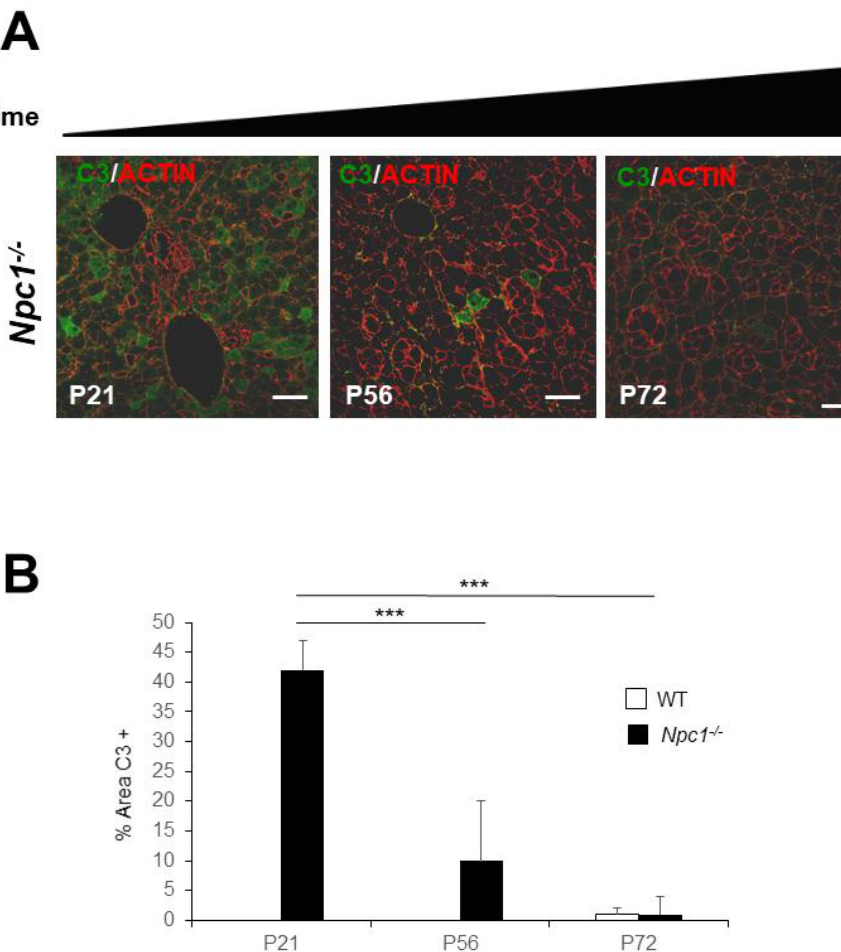
Figure 1. Complement component C3 (C3) deposits in Niemann–Pick type C (NPC) mouse livers decreases with aging. ( A ) Immunohistochemistry of Npc1 −/− mice livers (P21, P56, and P72 days old) showing C3 (green) and co-stained with Phalloidin-Texas red (red). ( B ) Quantification of the percentage of the area occupied by C3 positive cells at different time points in wild-type (WT) and Npc1 −/− tissues. Data are presented as means ± SD. ( n = 5 animals/group, two-way ANOVA and Tukey’s multiple comparison post-test). *** p < 0.01, compared to the Npc1 −/− group. Scale bars are 50 µm.